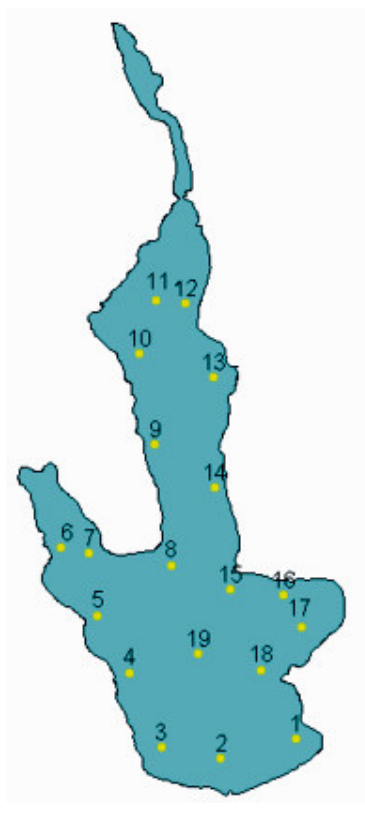
FIGURE 4 . WQ measurement station locations in the Küçükçekmece